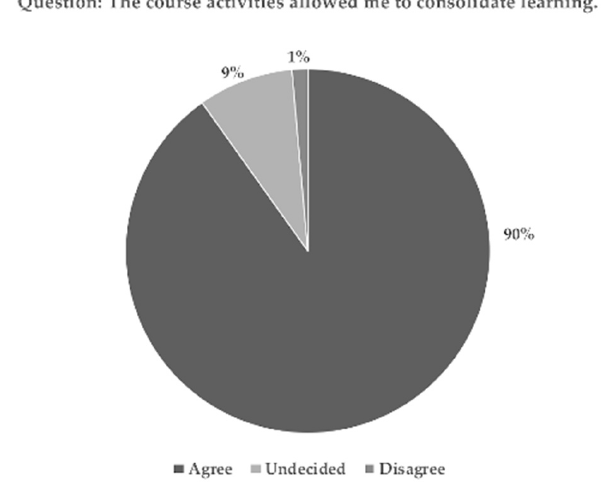
Figure 10. Students’ opinions on the effectiveness of learning activities.